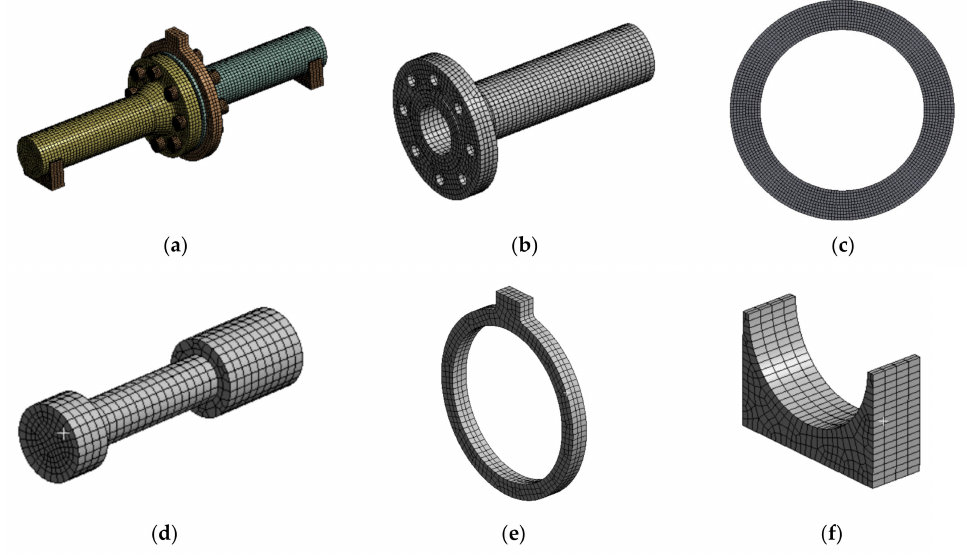
Figure 8. Discretization of individual elements of the analysed pipeline fragment: ( a ) assembly; ( b ) flange; ( c ) gasket; ( d ) bolt; ( e ) ring; ( f )